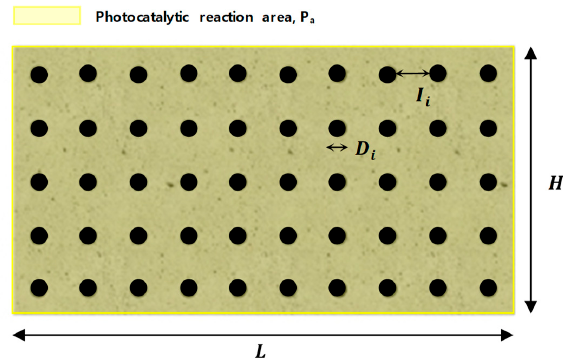
Figure 17. An example of photocatalytic transparent plastic bar reinforced concrete.